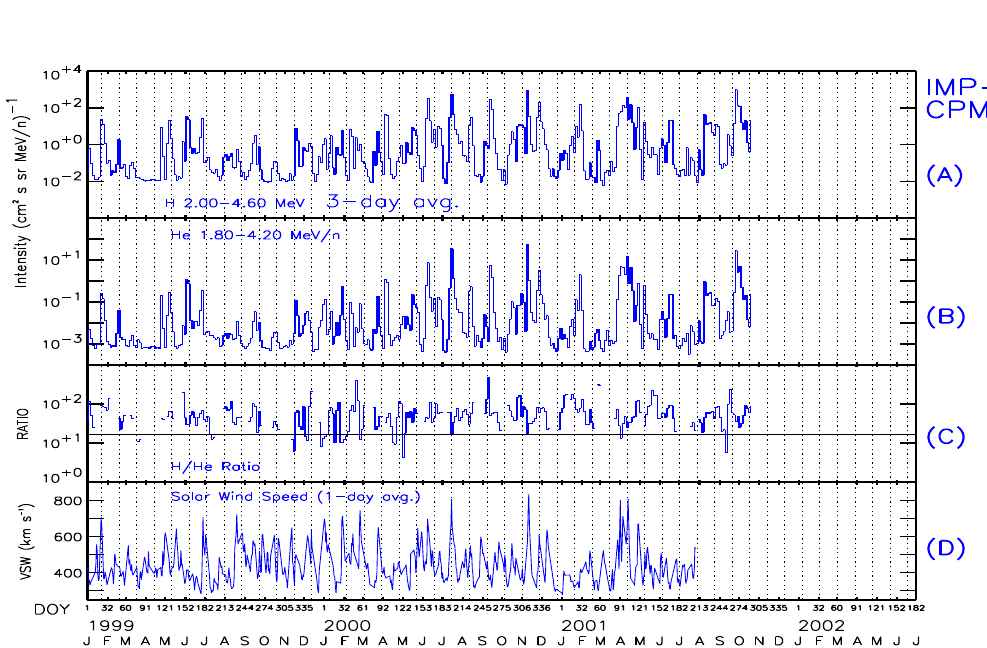
Fig. 3. Three-day averages of the (A) 2.00–4.60 MeV proton intensity and (B) 1.80–4.20 MeV/nucleon helium intensity as measured by the CPME instrument on IMP-8 (Sarris et al., 1976). (C) H/He ratio calculated from the H and He traces shown in panels (A) and (B). (D) Daily averages of the solar wind speed as measured by the MIT instrument on IMP-8. The top set of four panels extends from 24 October 1992 to 23 April 1996 and the bottom set from 1 January 1999 to 1 July 2002. In the top graph, the occurrence of transient particle events is indicated by T s in the panel (C), and the periods dominated by recurrent particle intensity enhancements are indicated by CIR. The vertical dotted lines are spaced every 27 days. The horizontal line in panel (C) marks a value of H/He ratio =